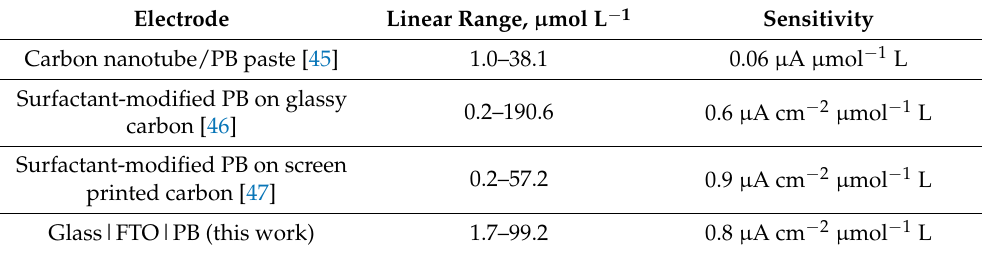
Figure 4. Linear dependence between reduction current of the glass|FTO|PB sensor at 0 V vs. Ag|AgCl, KCl sat. and concentration of FCL ions in PBS. Inset, the chronoamperogram from which cathodic current values for each concentration of FCL in PBS were determined. Table 1. Comparison of analytical characteristics of PB-based FCL sensors.